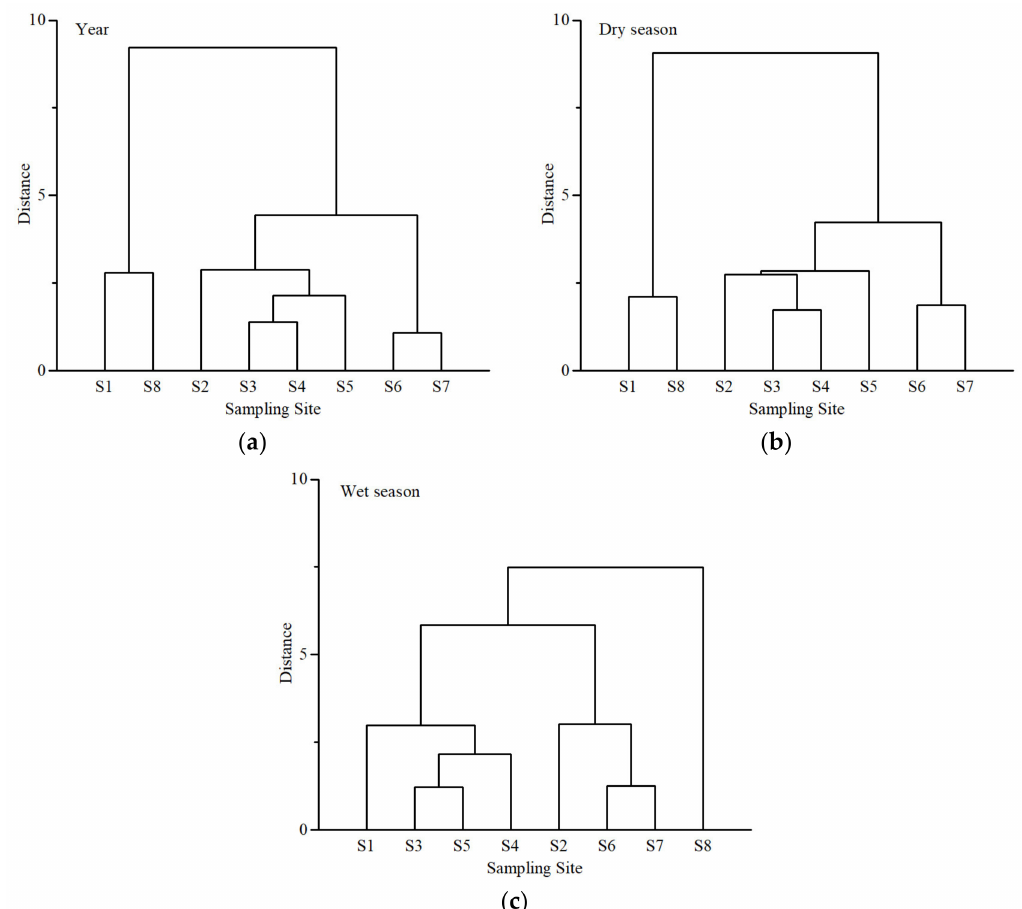
Figure 6. Clustering dendrograms of all years, as well as the dry and wet seasons. ( a ) Year; ( b ) Dry season; ( c ) Wet